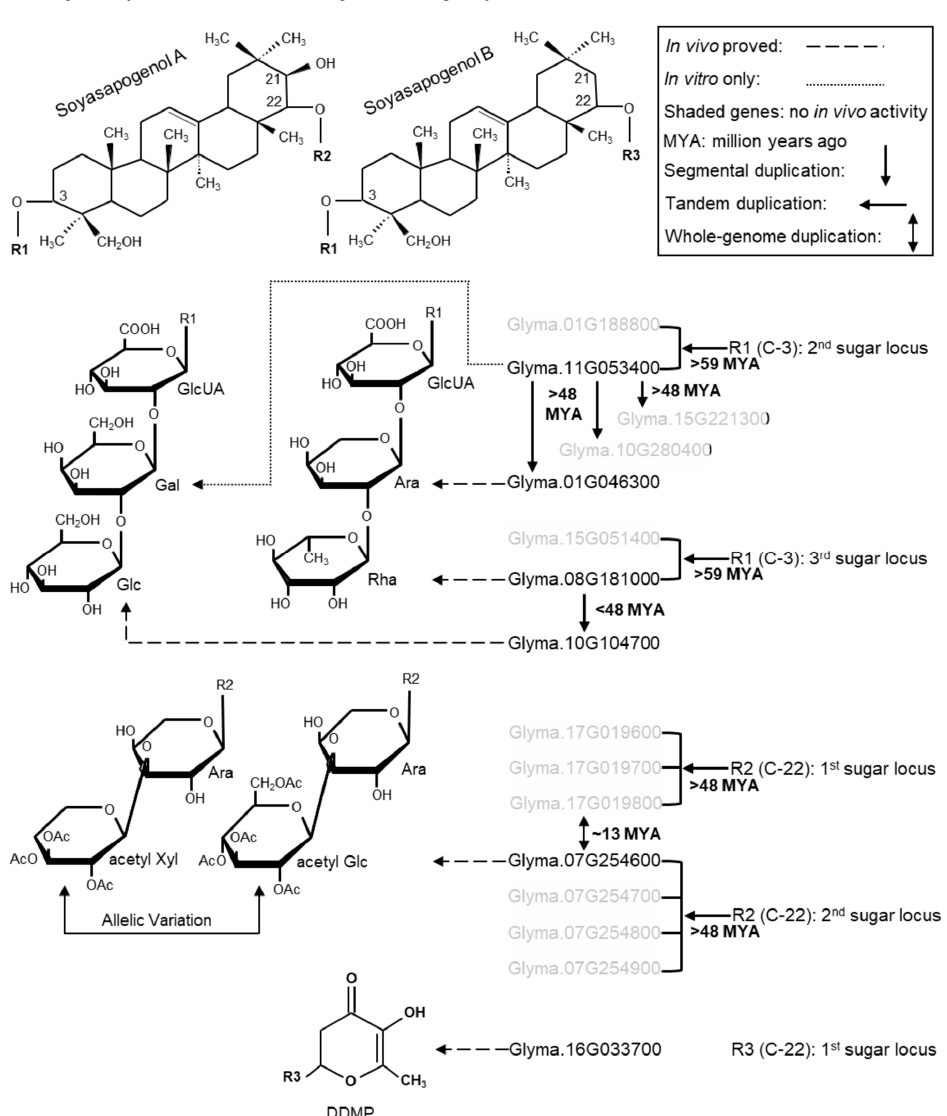
Figure 6. Duplication history and evolutionary fates of soyasaponin-related UGT loci. From top to F6 bottom, structures of soyasapogenols A and B, major C-3 sugar chains, C-22 sugar chains and DDMP sugars are shown. Soyasaponin-related UGTs with their duplication history are shown on the right side of sugar chains. Divergence period of each duplication events is inferred based on the presence of corresponding homologs in other legumes (see Discussion Sections 3.2.1 and 3.2.2). Shaded genes